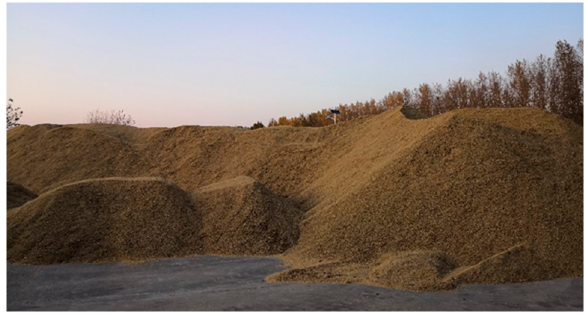
Figure 4. Rice plants were piled in the field after harvest.